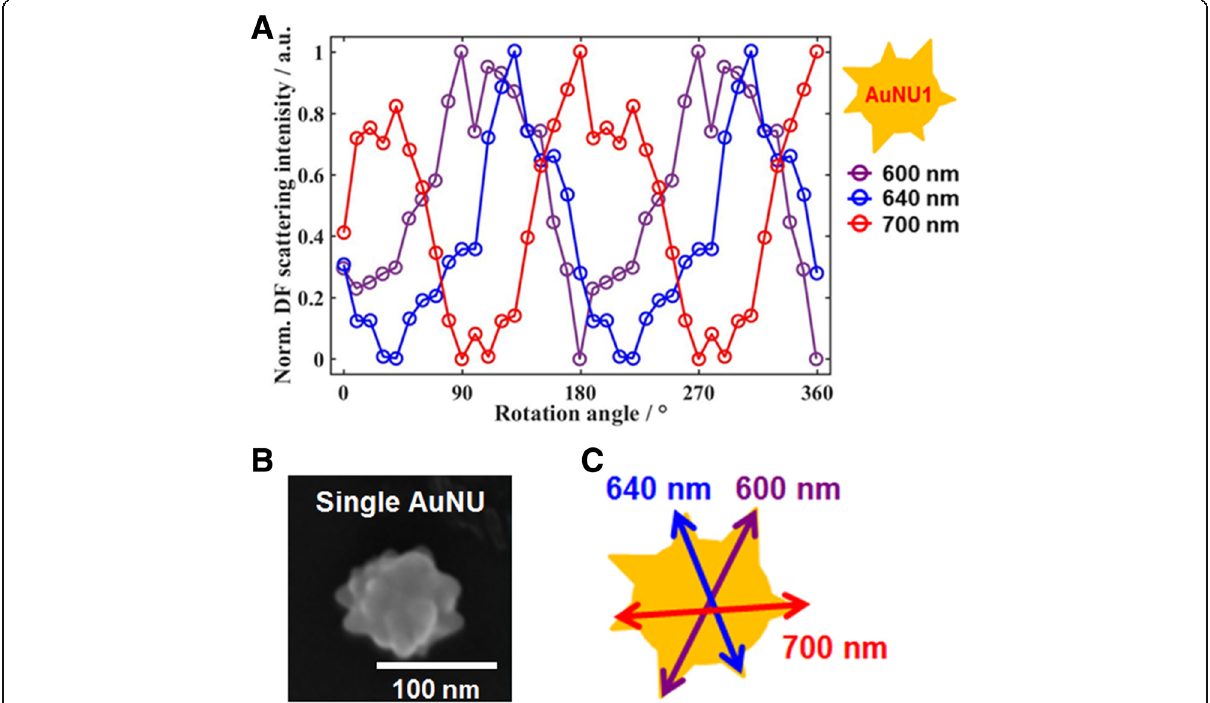
Fig. 3 a Normalized DF intensities for AuNU1 at the three different LSPR wavelengths as a function of the rotational angle. b Enlarged SEM image of a single AuNU with a spiky uneven surface. c Schematic diagram showing the generation of single dipoles with different wavelengths in multiple directions on the same AuNU surface